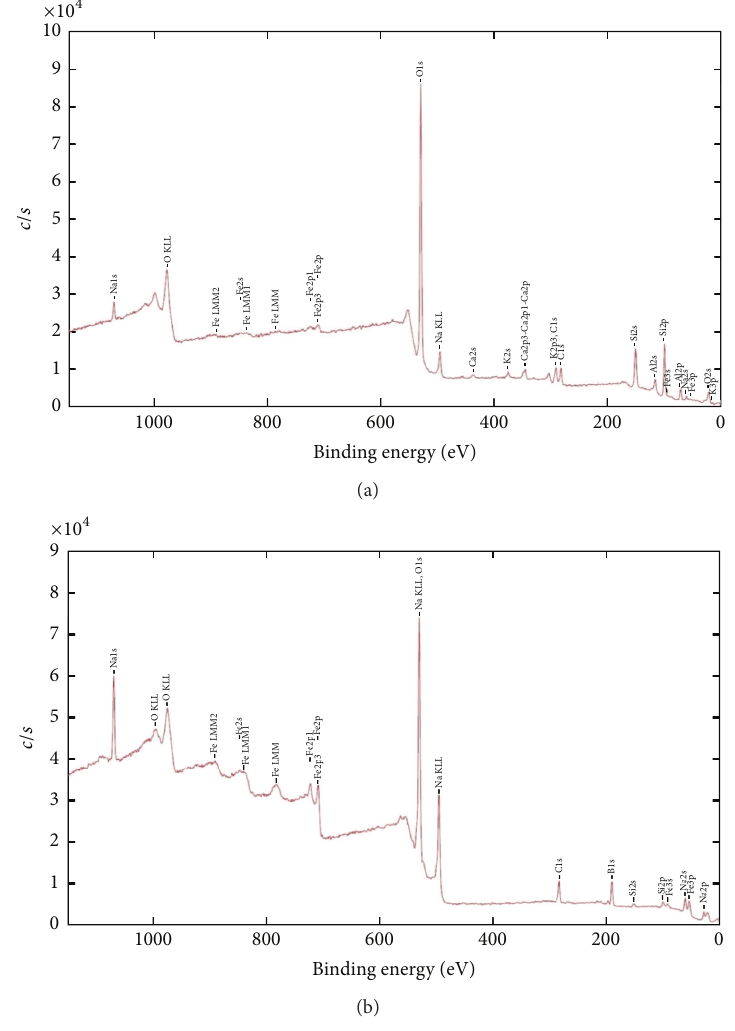
Figure 2: XPS spectrums of bare pumice (a) and P-nZVI (b).